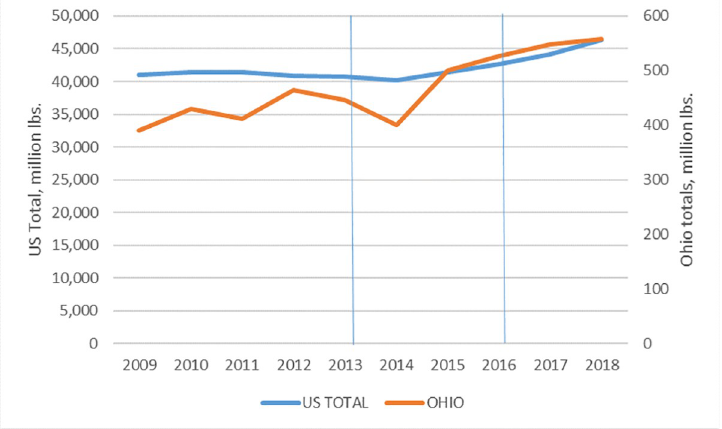
Fig 5. Cattle production, measured in pounds, 2009–2018. (Source, USDA). Vertical lines indicate the beginning of voluntary (left) and mandatory (right) compliance with the FDA’s GFI #213, restricting use of antibiotics in